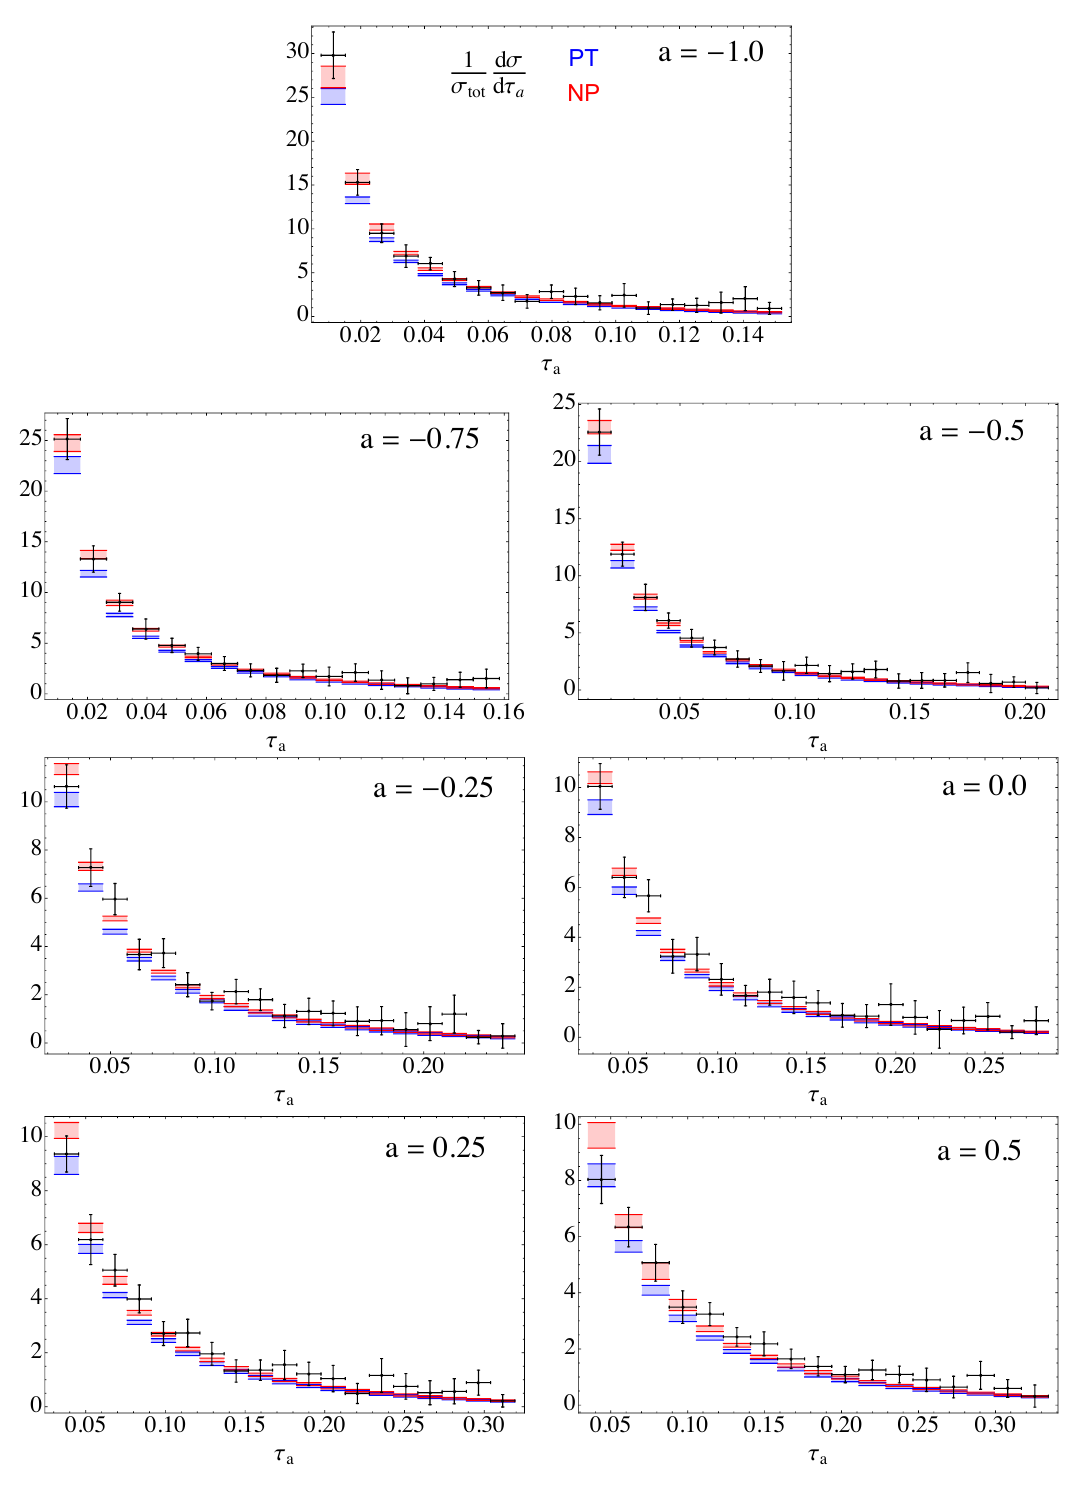
Figure 16 . The same as in (cid:12)gure 15, but with Q = 197 GeV.